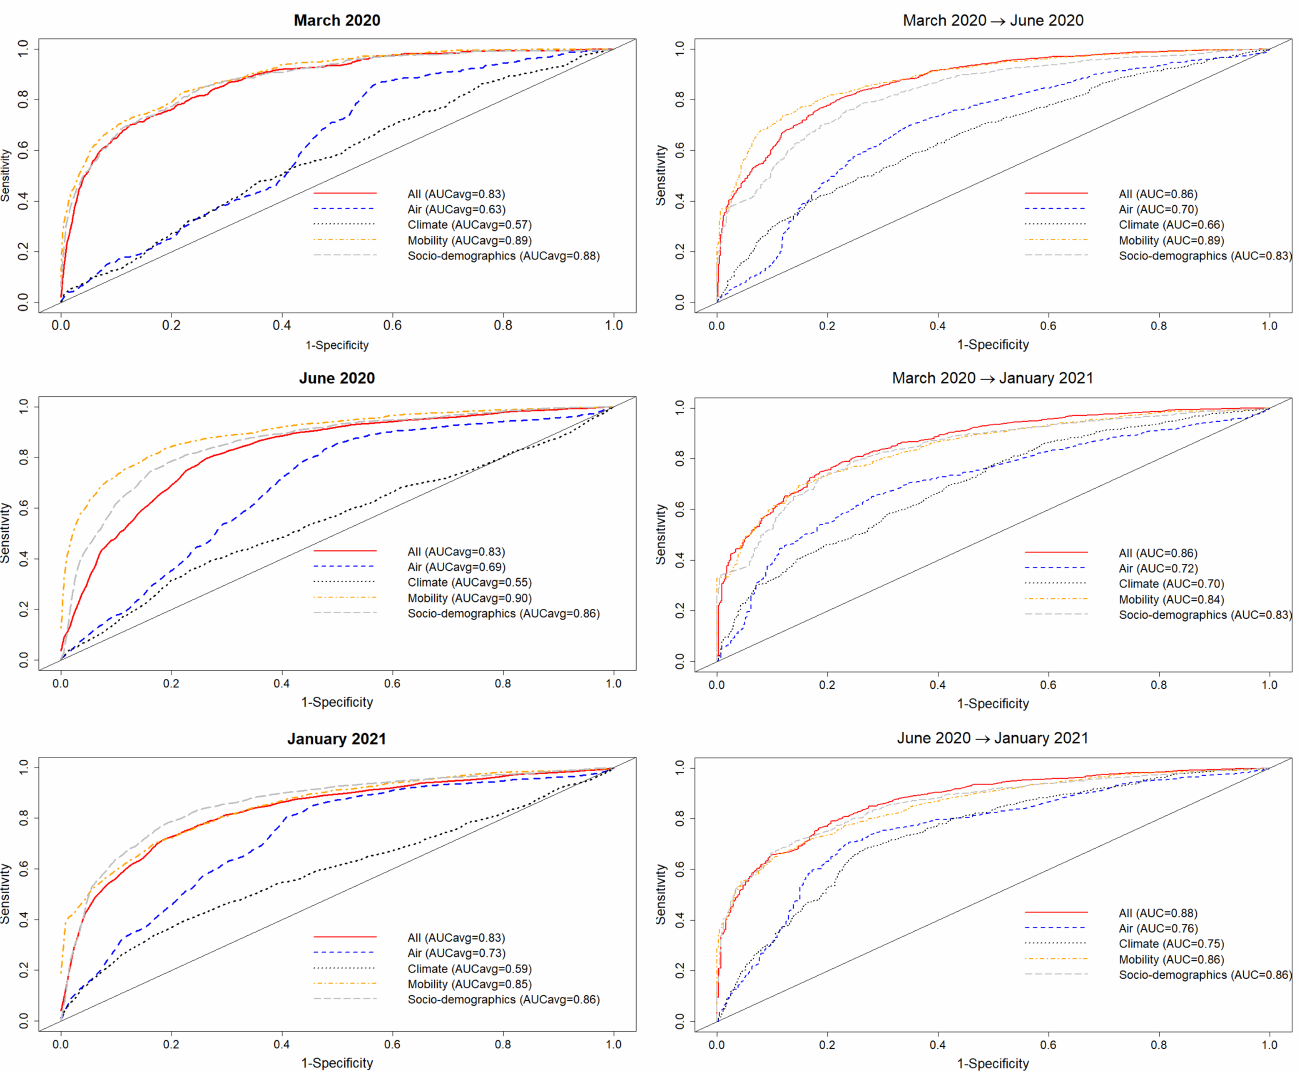
Figure 4. Left: Performance for five different SDMs for the class—presence of COVID-19 cases in the municipality—according to the habitat variable group considered (mobility, socio-demographics, air, climate, and all) for three different months of the pandemic. Five different train-test 70%–30% splits were considered for each month; Right: Performance for five different SDMs for the class presence of COVID-19 cases in the municipality according to the habitat variable group considered (mobility, socio-demographics, air, climate, and all) using a model trained on one month and tested on a future